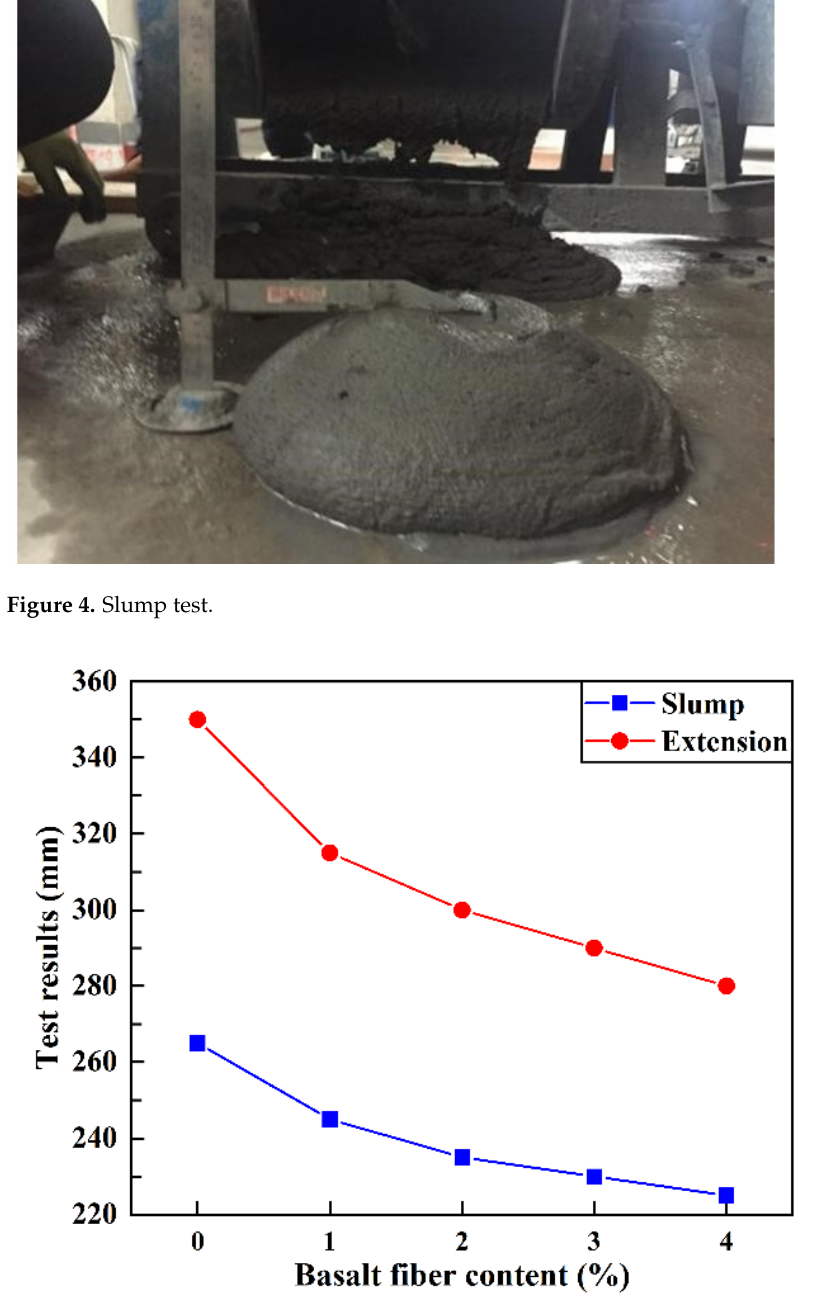
Figure 5. The test results of slump and extension.